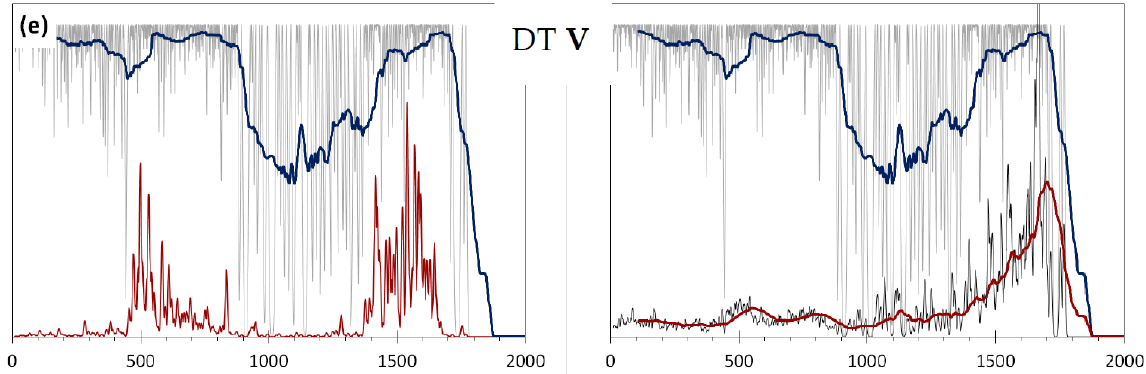
Figure 2. The virtual one-phonon IR absorption ( left ) and Raman scattering ( right ) spectra of DTs I – V against the background of their DOVs. The Raman spectra and DOVs plots are accompanied with 100-point trendlines. UHF AM1 calculations. The DT equilibrium structures are presented in Table 1 ( a , b ) and Table 2 ( c – e ).